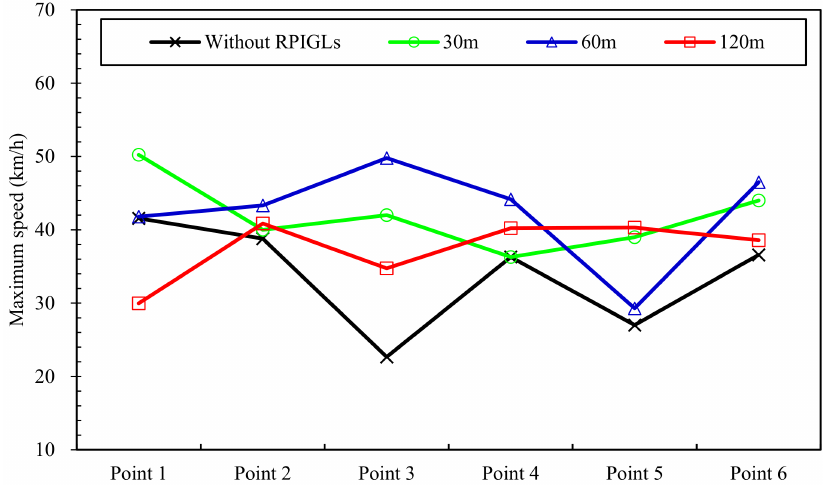
Figure 10. Minimum speeds of vehicles controlled by RPIDLs with different group